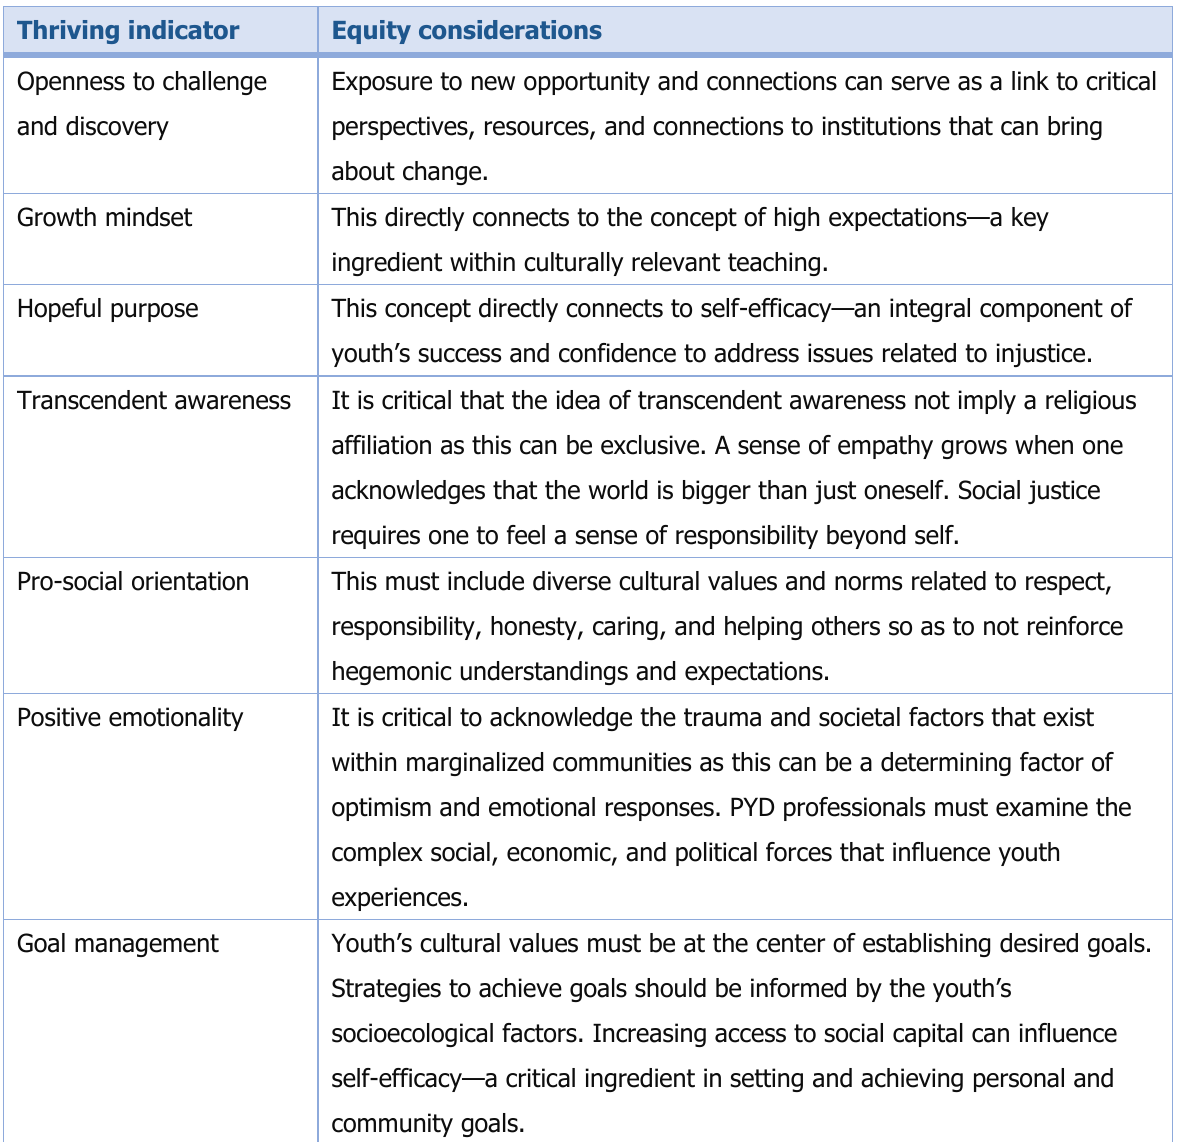
Table 3. Equity Considerations for 4-H Thriving Indicators Thriving indicator Equity considerations Openness to challenge and